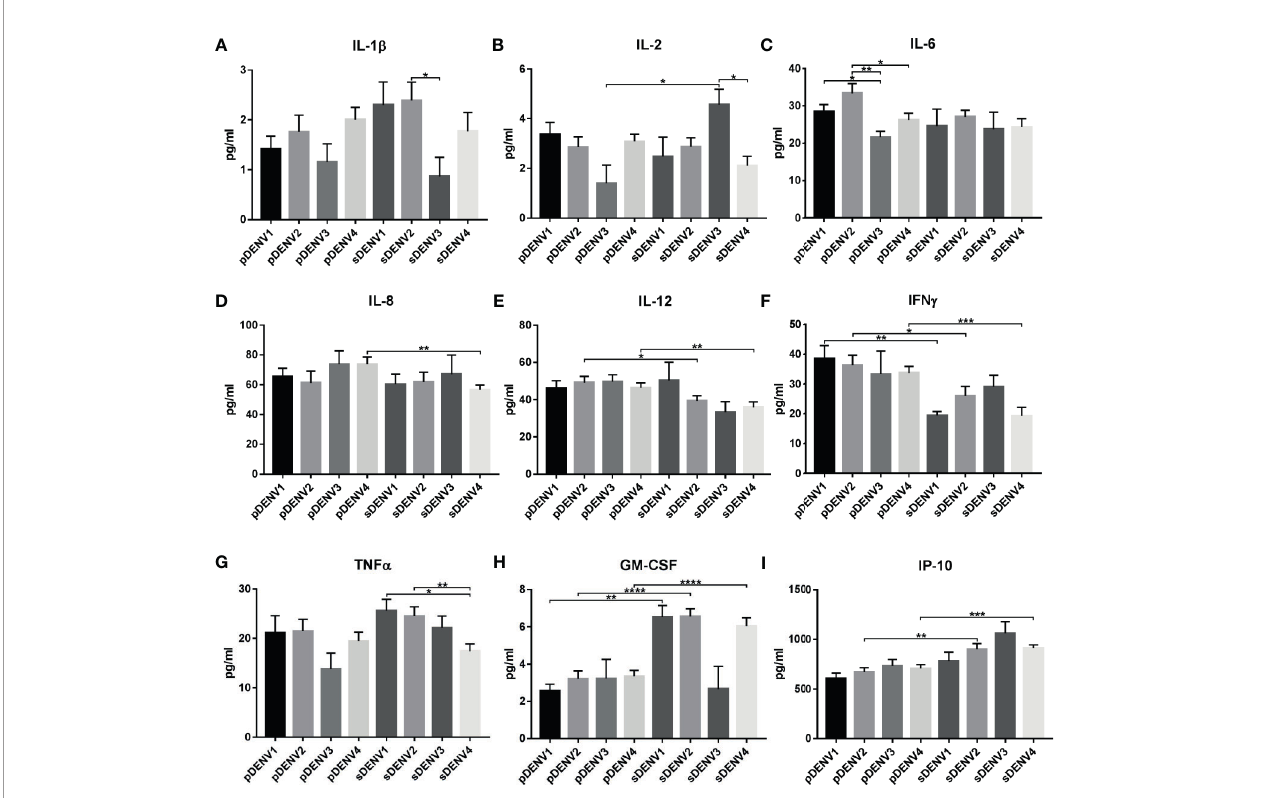
FIGURE 6 | Cytokine expression in primary and secondary infection in different serotypes. The graph represents the cytokine expression within primary and secondary DENV infection. The statistically signi fi cant cytokines are (A) IL-1 b , (B) IL-2, (C) IL-6, (D) IL-8, (E) IL-12, (F) IFN g , (G) TNF a , (H) GM-CSF, and (I) IP-10. Statistical signi fi cance is shown in asterisk (*) mark. * P < 0.05, ** p < 0.01, *** p < 0.001, **** p < 0.0001. The error bars represent SEM. [pDENV1 (N=10), pDENV2 (N=13), pDENV3 (N=4), pDENV4 (N=22), sDENV1 (N=4), sDENV2 (N=9), sDENV3 (N=3), sDENV4